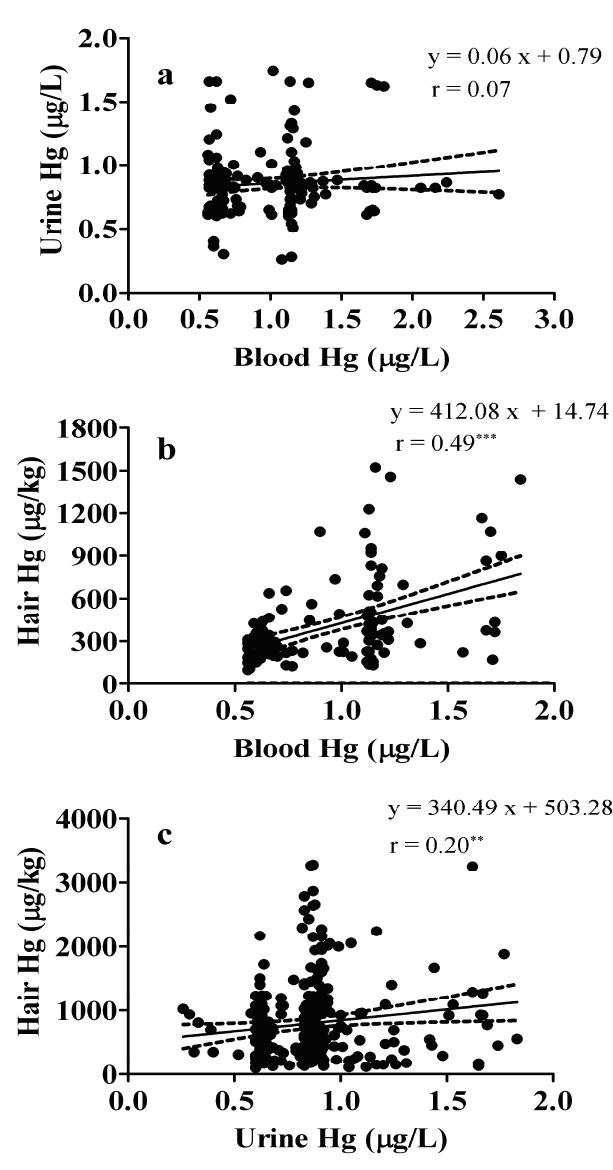
Figure 3. Correlations between ( a ) blood and urine mercury levels, ( b ) blood and hair